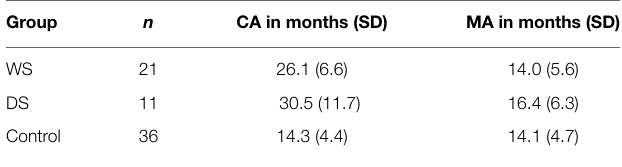
TABLE 1 | Mean (SD) chronological age (CA) and mental age (MA) for each